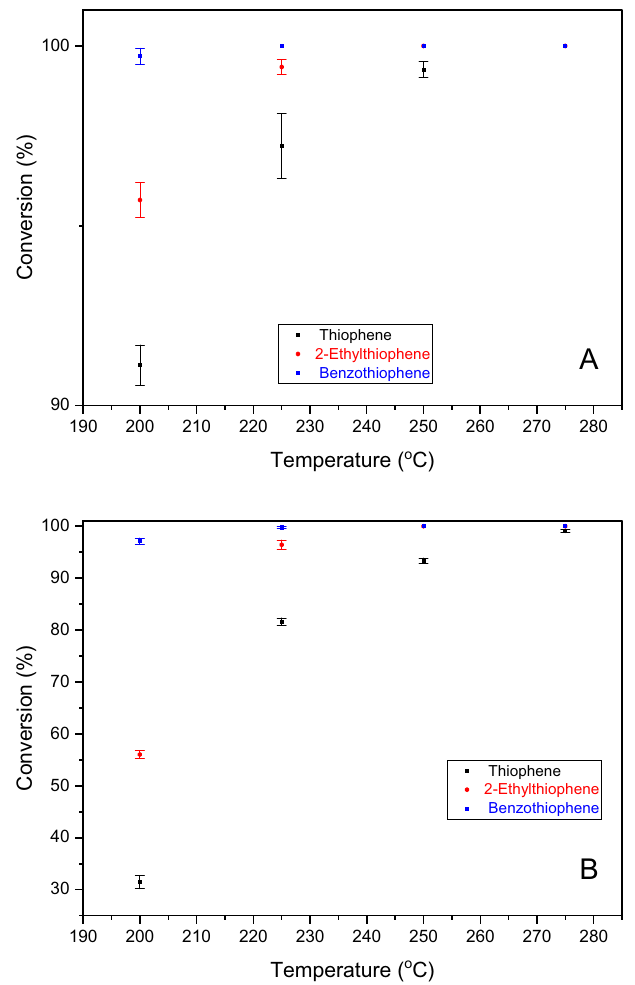
Figure 11. Conversion with temperature over CoMo/γ-Al 2 O 3 -Nb 2 O 5 ; ( A ) single sulfur compound HDS (T, 2-ET, BT); ( B ) mixture of sulfur compounds HDS (T + 2-ET +